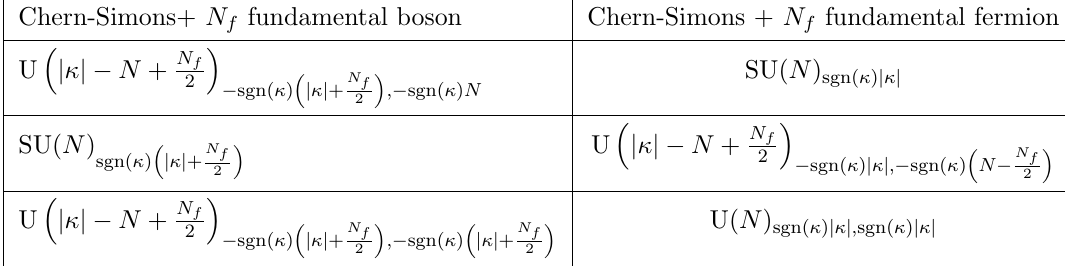
Table 3. We list non-supersymmetric dualities obtained by (cid:13)owing from (E.1), (E.2). (cid:13)ows (and assertion of their dual equivalence) is reliable only when the